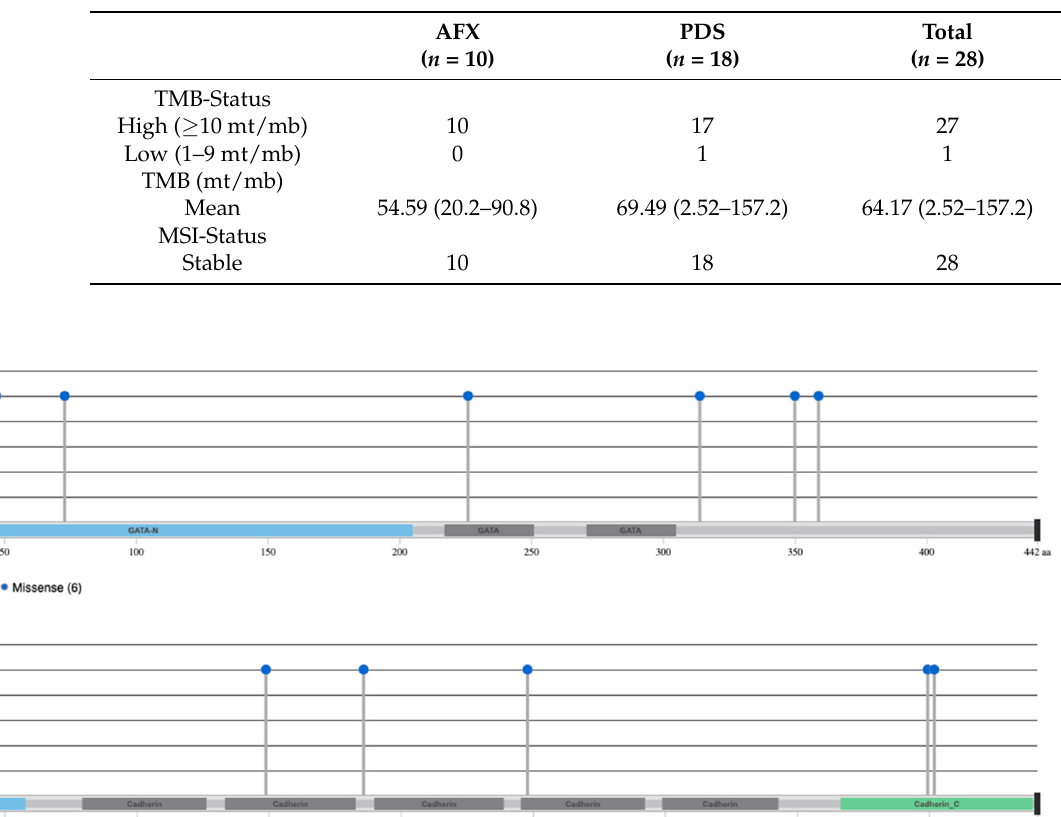
Table 2. Tumor Mutational Burden (TMB) and Micro-Satellite Instability (MSI) status of all analyzed tumor samples.